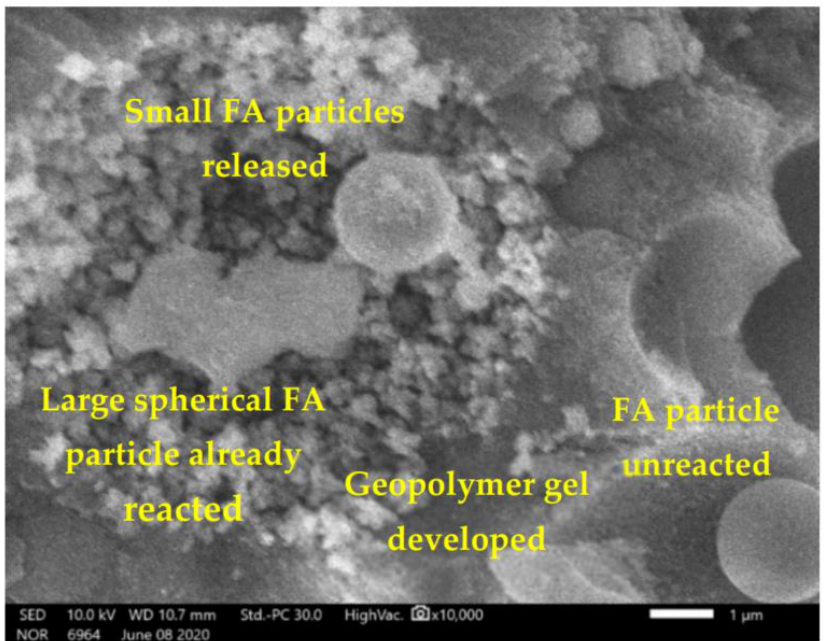
Figure 12. A large size FA particle already reacted; smaller FA particles still unreacted.